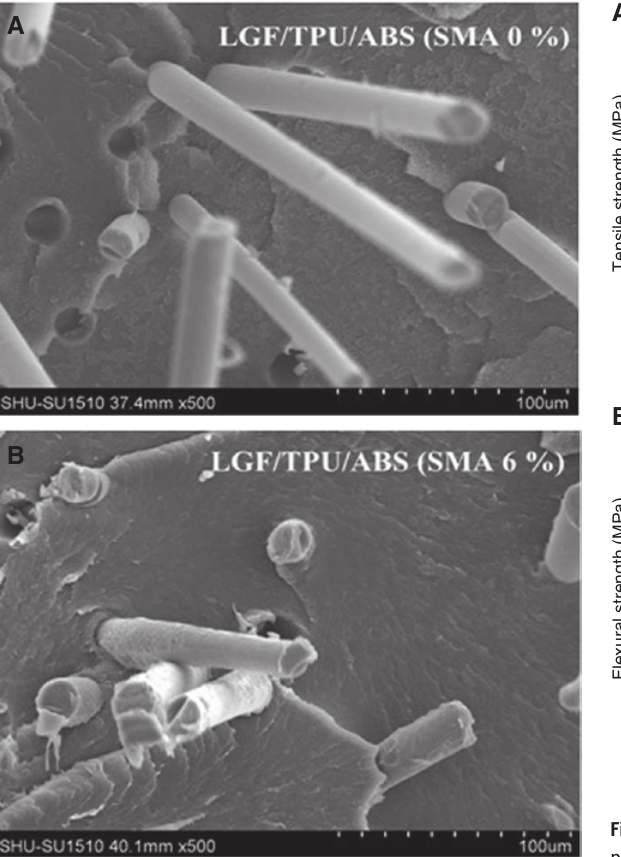
Figure 6 SEM micrographs of the composites.